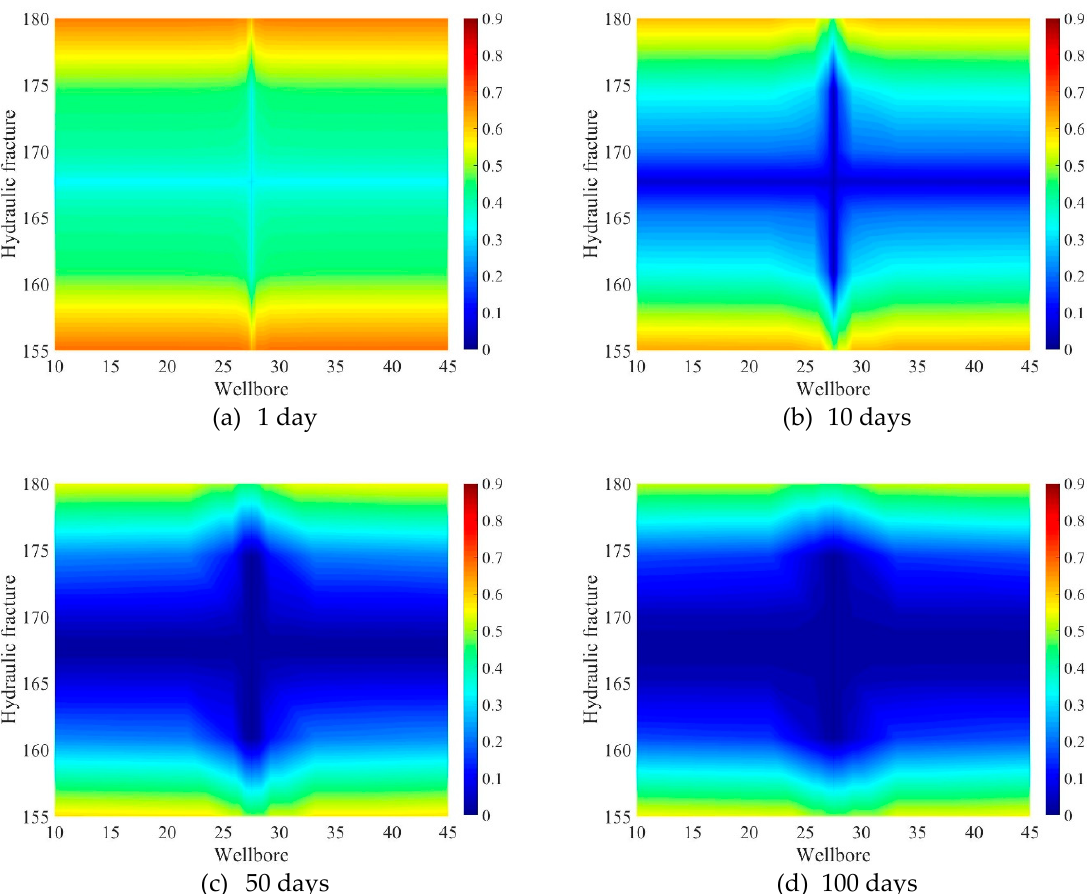
Figure 5. The distribution of gas saturation in inorganic matrix in effectively stimulated reservoir volume (ESRV).